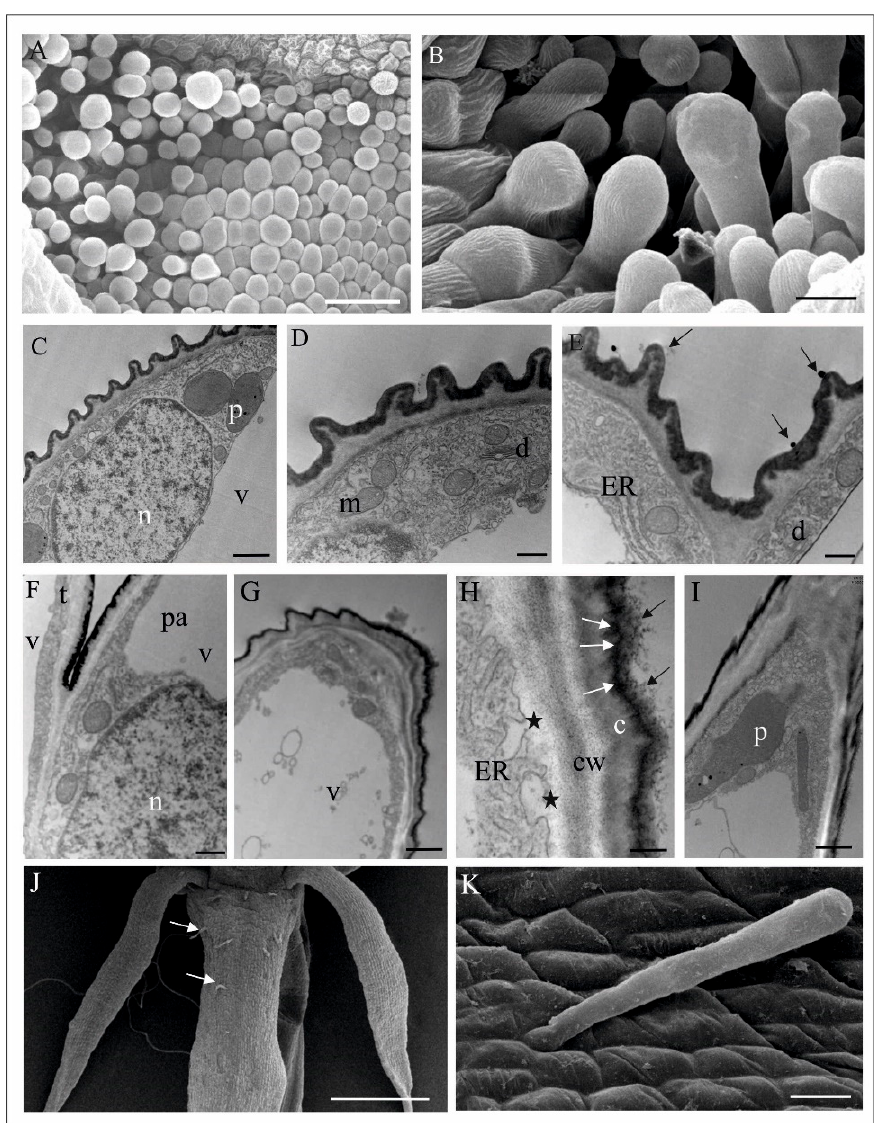
Figure 4. Papillae and trichomes in the folded margins of M. monophyllos labellum (A-I) (Figure 2B— marked with 3). ( A ) Papillae and trichomes—top view (SEM); ( B ) trichomes with the cuticular striations—side view (SEM); ( C – E ) ultrastructure of the lenticular-convex papillae (TEM); outer cell wall with appendages covered with cuticle and remnants of secretive materials ( arrows), the cytoplasm containing plastids with plastoglobuli, mitochondria, dictiosomes, polyribosomes on the surface of an ER cisterna and numerous vescicles; ( F – I ) ultrastructure of the trichomes (TEM): fragment of the lower part of the two trichomes ( F ): bicellular (t) and unicellular, finger-like (pa); the cells of both trichomes highly vacuolated; ( G – I ) details of bicellular trichome: ( G ) part of the one-cell stalk, under the head cell; ( H , I ) Part of the longitudinal section through the strongly vacuolated head cell of trichomome; the cell wall with thickened irregularly, with protrusions; huge amounts of secreted material (black arrows) on the cuticle surface and streaks of such material transported across the cell wall (white arrows); an extensive system of ER cisternae in the cytoplasm; the vesicles incorporated into the plasmolemma release their contents to the outside (asterisk); ( J , K ) 3-cells trichomes on a dorsal sepal (white arrows) (SEM). Scale bars: 50 µm, 20 µm, 1 µm, 500 nm, 500 nm, 500 nm, 1 µm, 200 nm, 1 µm, 500 µm, 20 µm. c —cuticle, cw —cell wall, d —dictiosome, ER — endoplasmic reticulum, m —mitochondrion, n —nucleus, p —plastid, v —vacuole.